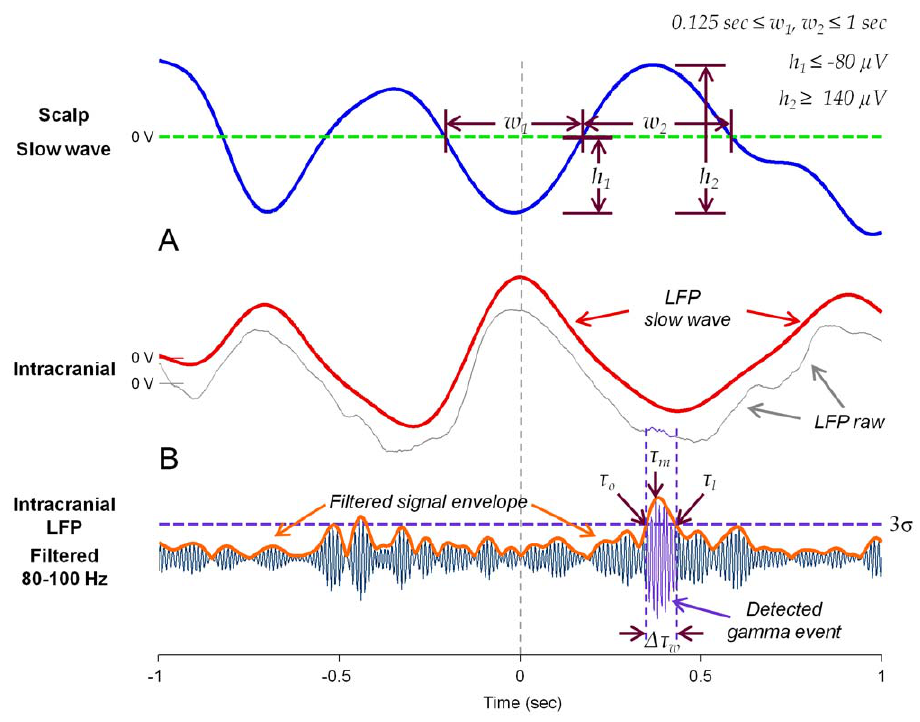
Figure 1. Automatic detection of slow waves and gamma events. ( A ) Examples of scalp ( blue line ) and intracranial ( red line ) detected slow waves, inside a 2-seconds window around the central peaks. Scalp slow wave were detected according to defined duration and amplitude criteria ( top right ). ( B ) Raw intracranial LFP ( gray line ) and the corresponding gamma event detected in the filtered LFP ( bottom ) when the amplitude of the envelope signal was over 3 s . Presented times and duration correspond to: t o R first detection time, t l R last detection time, t m R maximal amplitude time, Dt w = t l 2 t o R total event duration.